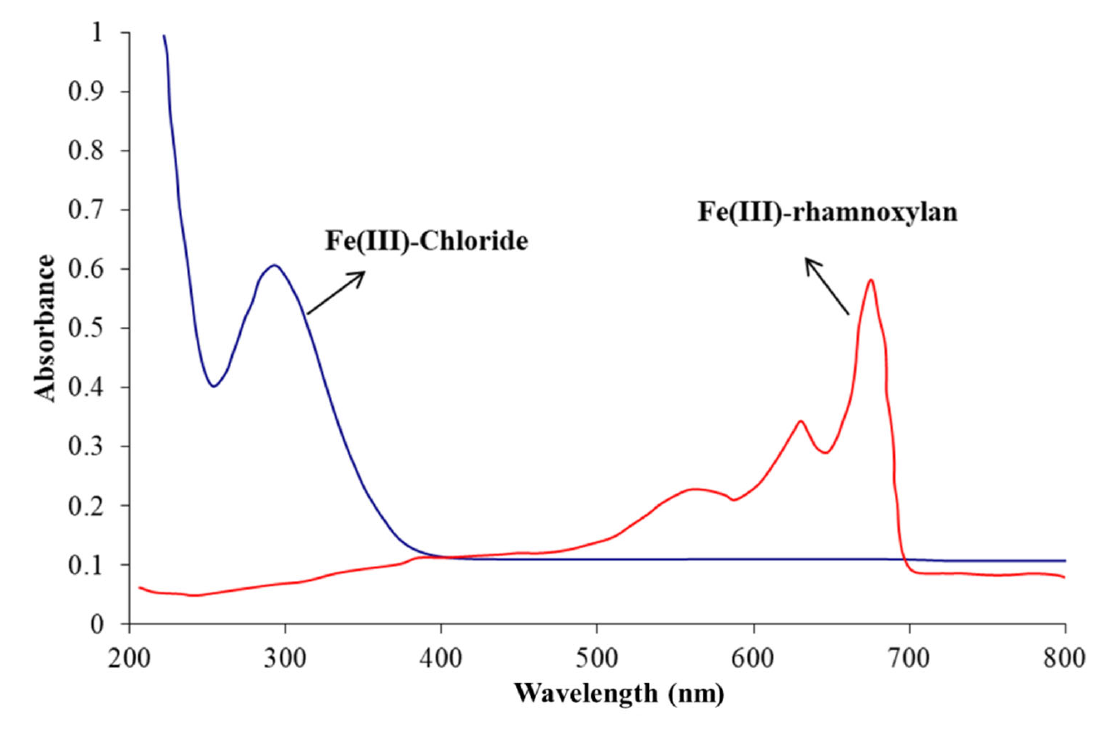
Figure 4. UV ‐ Vis spectra of FeCl 3 ∙ 6H 2 O (in water) and Fe(III) ‐ rhamnoxylan (diffuse reflectance). Figure 4. UV-Vis spectra of FeCl 3 · 6H 2 O (in water) and Fe(III)-rhamnoxylan (diffuse reflectance).